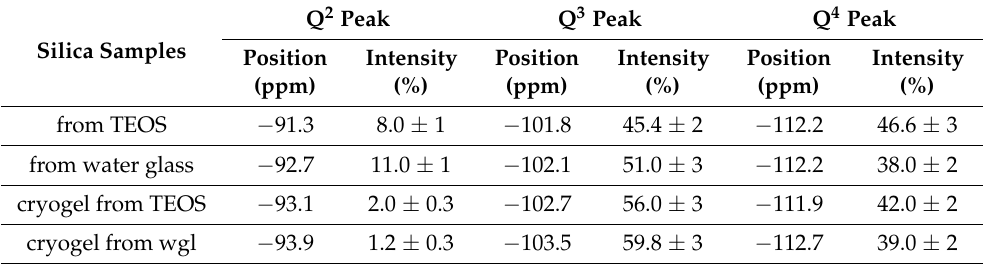
Figure 4. 29 Si MAS NMR spectra of cryogels (from water glass or TEOS), alcogel (from TEOS), and hydrogel (from water glass, wgl). hydrogel (from water glass, wgl). Table 3. Si MAS NMR spectroscopy